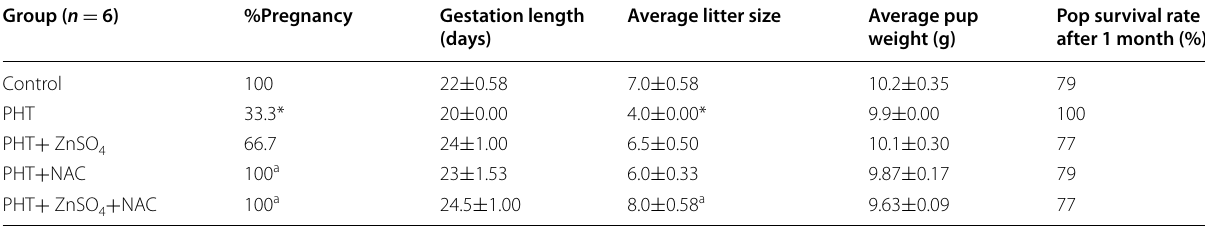
PHT phthalate, ZnSO 4 zinc sulfate, NAC N-acetylcysteine * ,a p < 0.05 was considered statistically significant when compared with the control and PHT-treated groups respectively